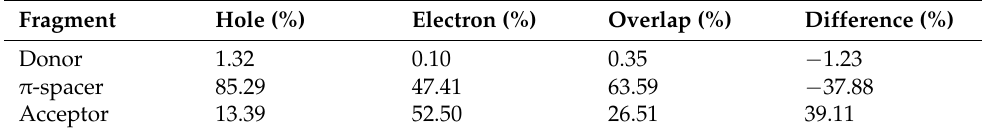
Table 7. Fragment contribution to electron–hole overlap in O4 .